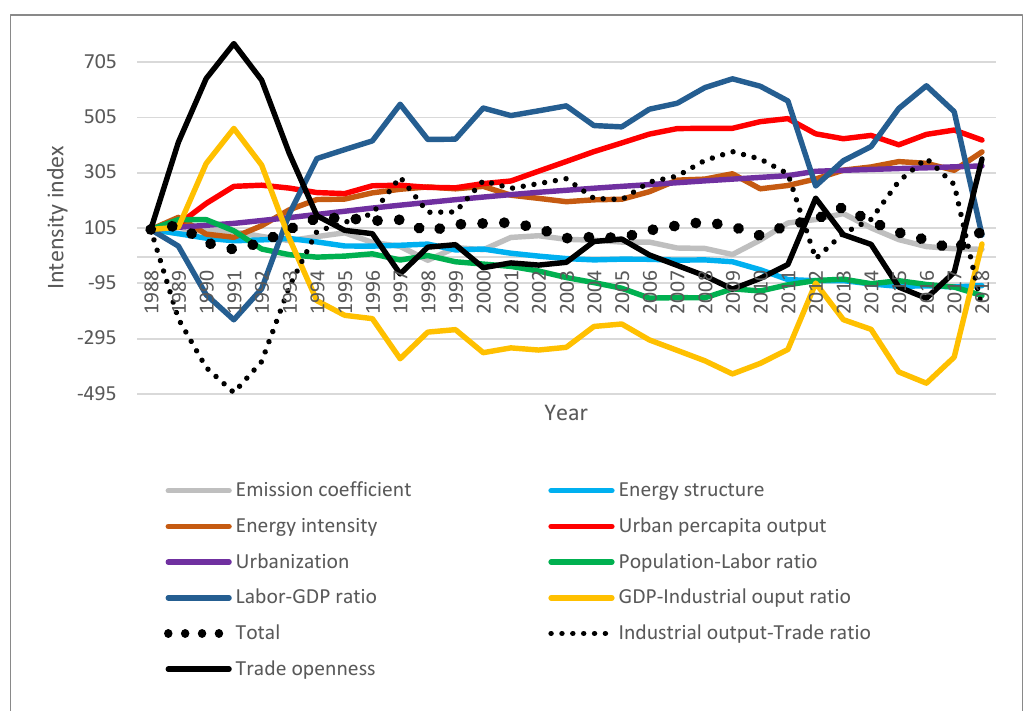
Fig. 9: CO 2 emission intensity and its components Fig. 9: CO 2 emi ssion intensity and its